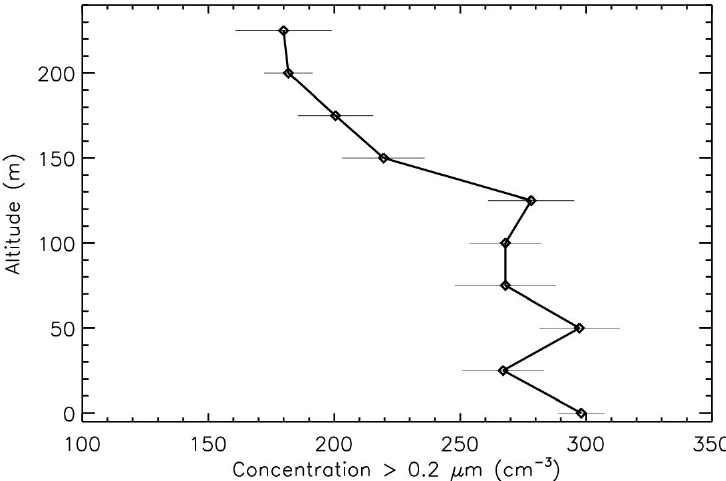
Figure 18. Vertical evolution of the number concentrations of particles greater than 0.2 µg ob-